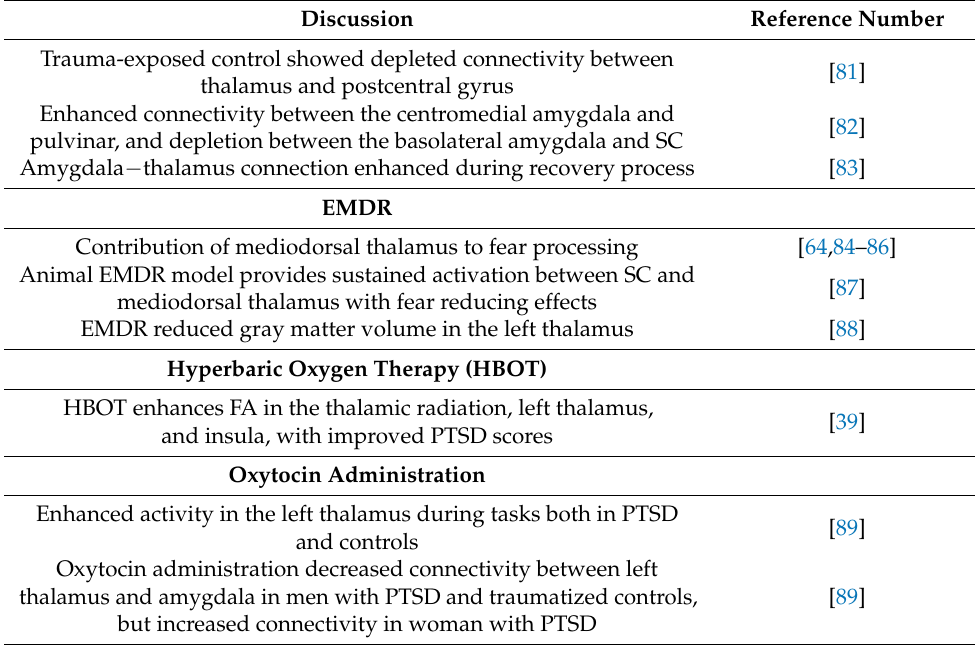
Table 4. The summary of literature research for therapy for PTSD related to